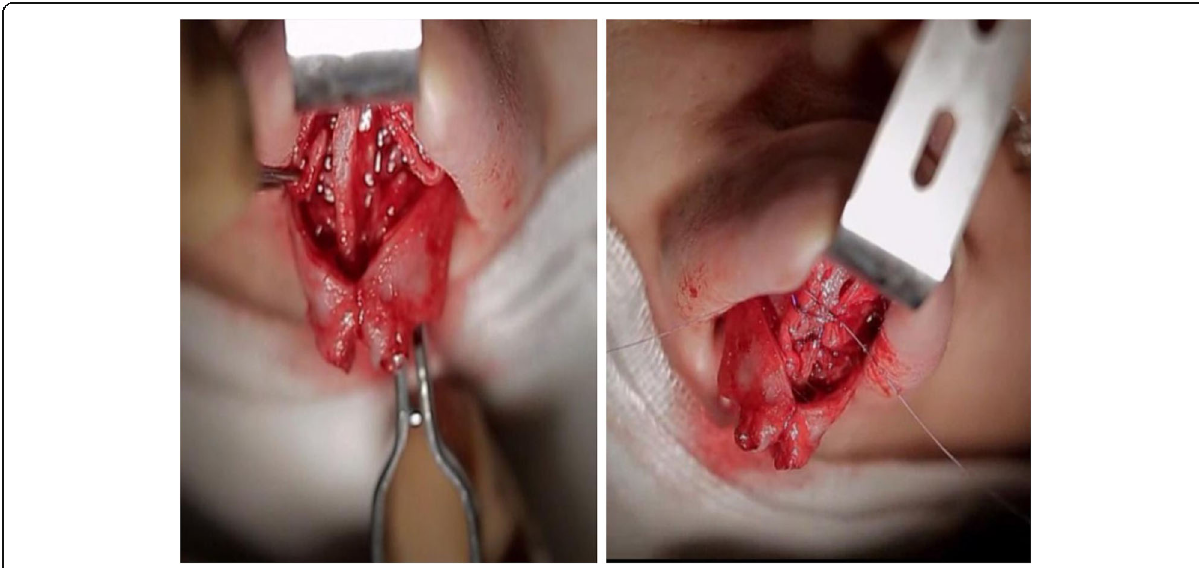
Fig. 4 Fixation of the folded ULC with a mattress suture in auto-spreader flap